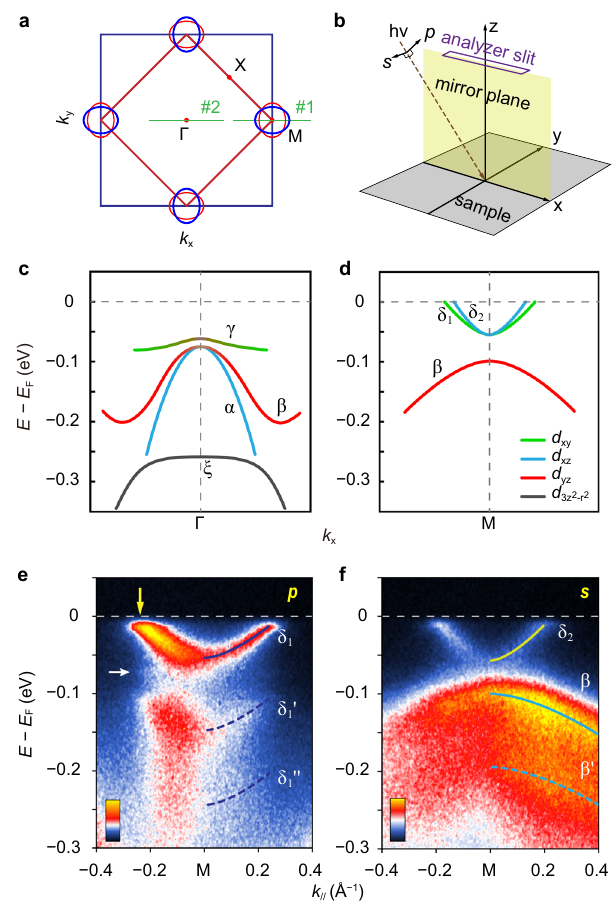
Fig. 1 ARPES characterization with polarized photons. a The 2-Fe (red square) and 1-Fe (blue square) Brillouin zones (BZs), and the sketch of Fermi surfaces (blue and red ellipses) of monolayer FeSe/STO 26 . The green lines are the two cuts for the ARPES in Figs. 1 – 4. b Experimental geometry for linear polarization-dependent ARPES, where p ( s ) indicates the electric fi eld of incident photon is parallel (perpendicular) to the emission plane de fi ned by the analyzer slit. c , d Schematic diagram of band structure and orbital characters of monolayer FeSe/STO at Γ and M points, respectively, as determined by this ARPES study and in agreement with refs. 26,27 . Here we use the same coordinate system as in b to de fi ne the d orbitals, i.e., x and y along the nearest Fe – Fe directions. Photoemission maps along cut #1, with 24 eV photons in p polarization ( e ) and s polarization ( f ). The solid and dashed curves indicate principal and replica bands with ~90 meV intervals, respectively. The white arrow indicates the other set of replica band at ~60 meV below the principal band. The yellow arrow indicates the Fermi momentum of the δ 1 band, where a superconducting gap is suppression of spectral background, enabling improved char- acterization of the replica bands.